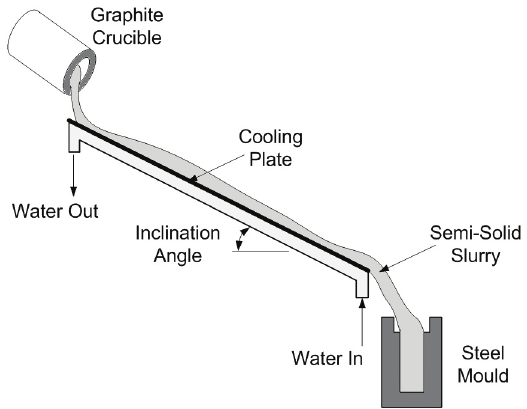
Figure 2. A schematic illustration cooling slope casting apparatus used in the present work.